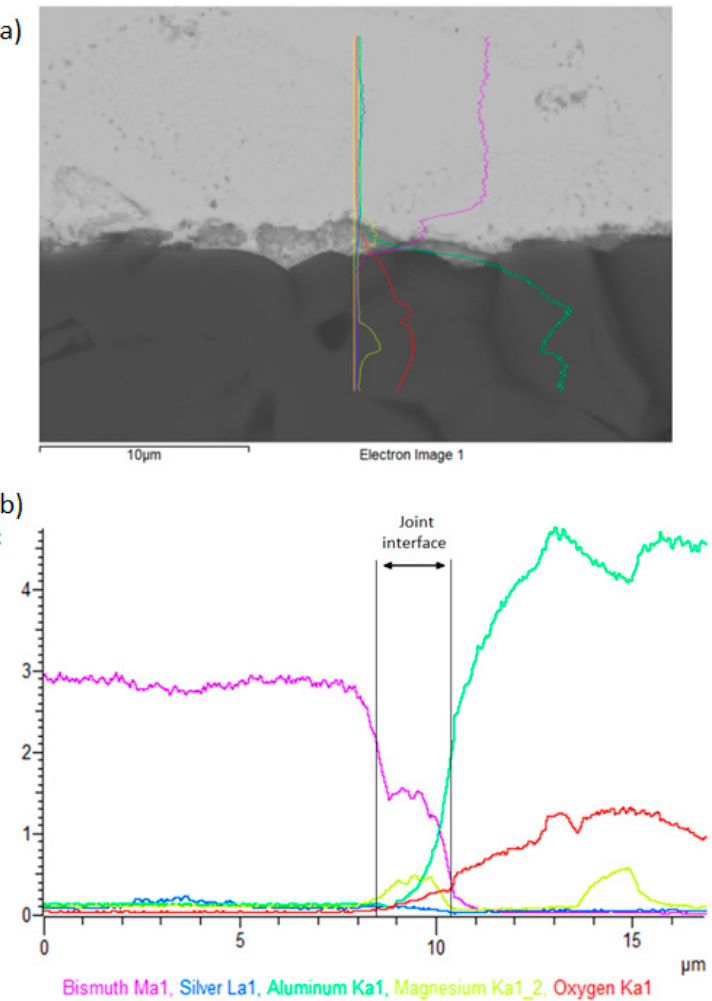
Figure 16. Line EDX analysis of the Al 2 O 3 /Bi11Ag1Mg joint: ( a ) transition zone with a marked line; ( b ) concentration profiles of Bi, Ag, Mg, Al, and O